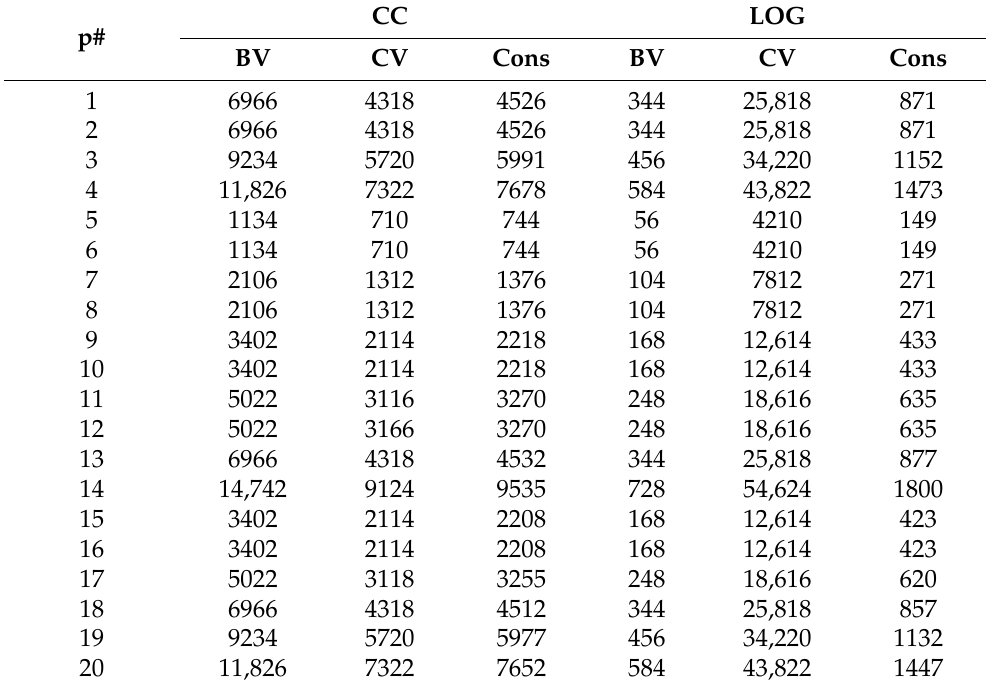
Table 3. The sizes of the instances produced by CC and LOG models with 10